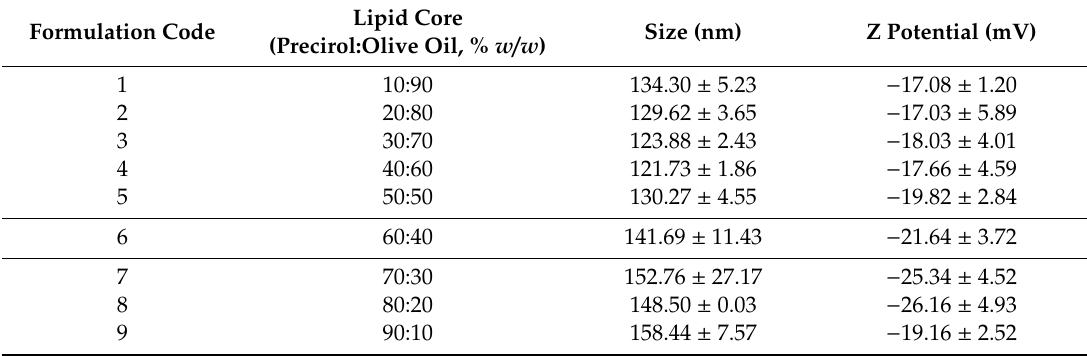
Table 1. Physico-chemical characterization of the developed nanoformulations with di ff erent solid lipid (Precirol ATO 5):liquid lipid (olive oil) ratio in the lipid core. Lipid Core Formulation Code (Precirol:Olive Oil, % w / w